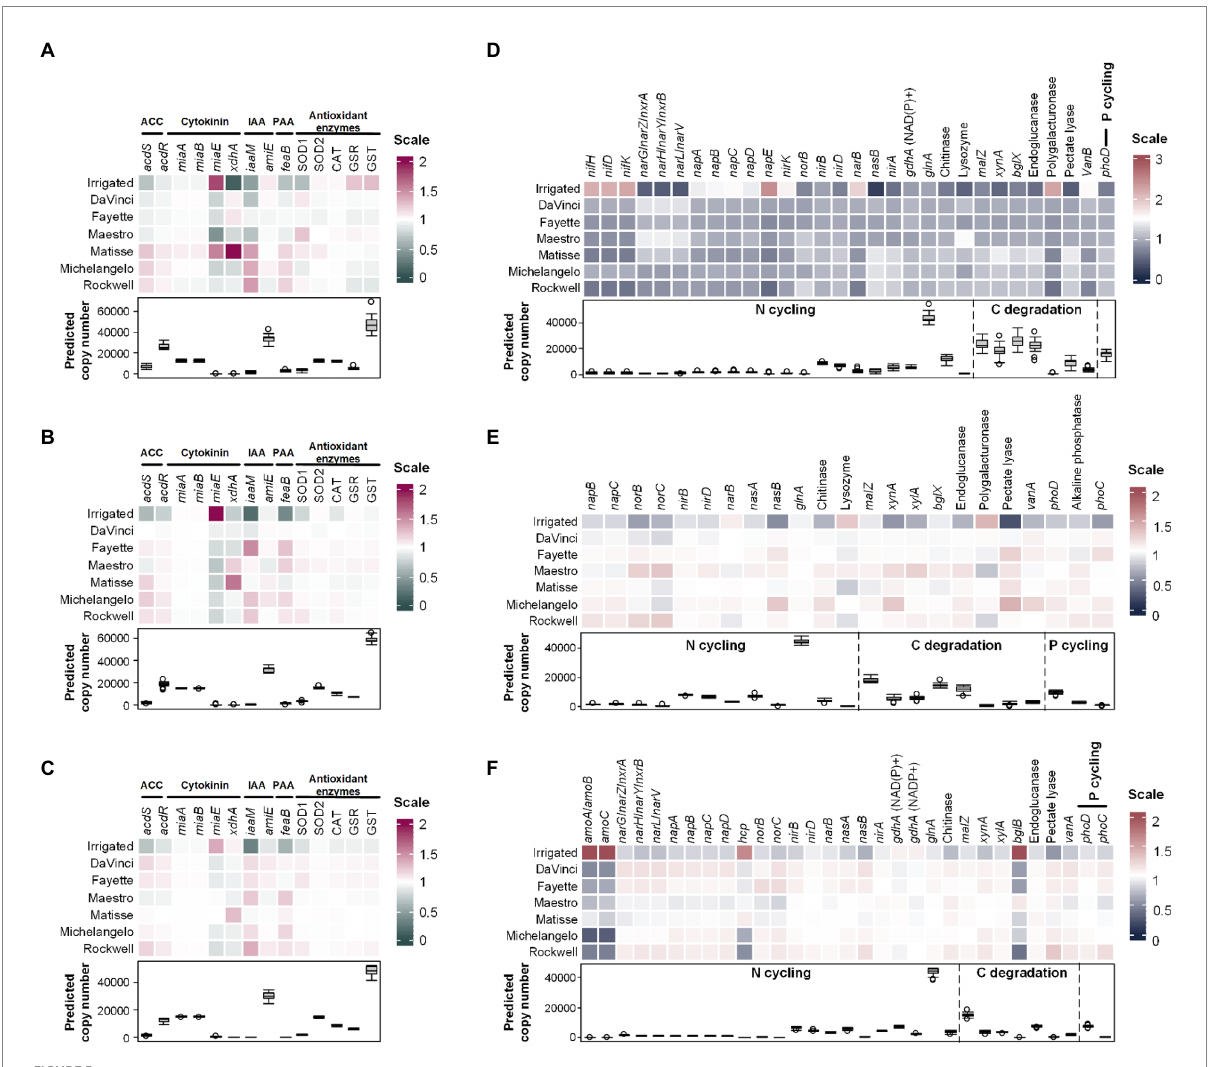
FIGURE 5 Heatmaps of normalized copy numbers of putative bacterial functional genes involved in production or regulation of phytohormones, antioxidants, and nutrient cycling at a sequence depth of 17,552. (A–C) are the phytohormone and antioxidants related genes in the root endosphere, rhizosphere, and bulk soil, respectively. (D–F) represent the nutrient cycling-related genes in the root endosphere, rhizosphere, and bulk soil, respectively. Only the genes that had significant differences between irrigation and no-irrigation were shown. Box plots show the average copy numbers of putative genes across all samples. ACC, 1-aminocyclopropane-1-carboxylic acid deaminase; IAA, indole-3-acetic acid; PAA, phenylacetic